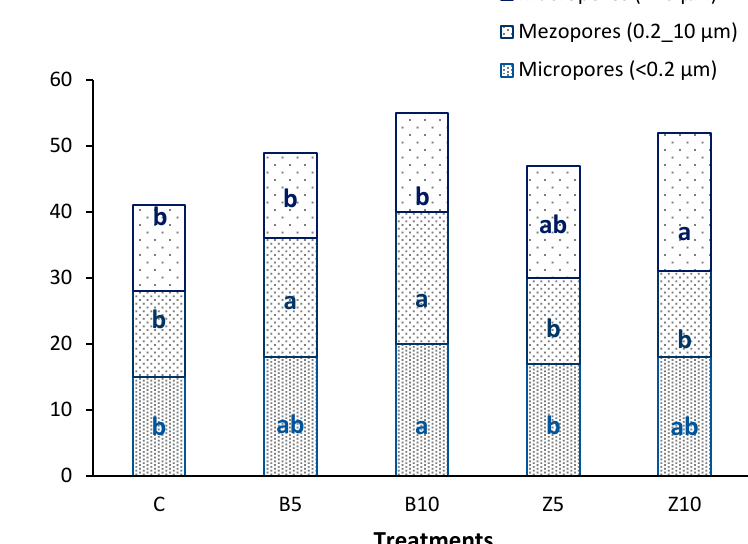
Figure 1. Effect of treatments on soil pure size distribution. Different lowercase letters with the same color indicate significant differences between means ( p < 0.05).